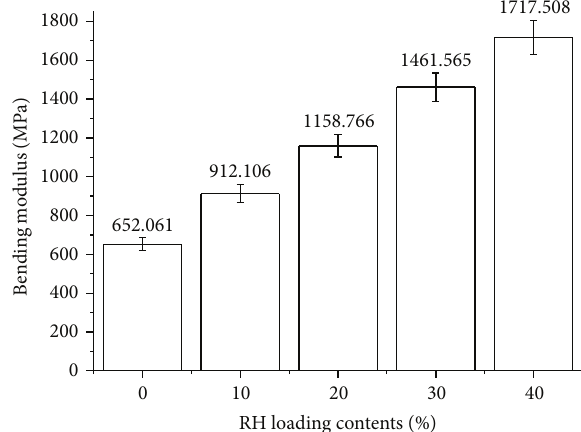
Figure 3: Bending modulus of composites with different loading of rice husk fibers.